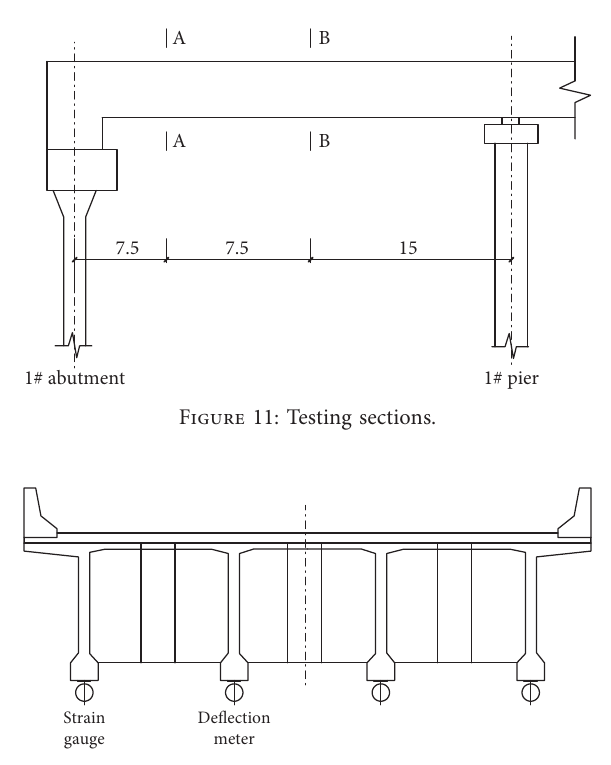
Figure 12: Layout of measuring